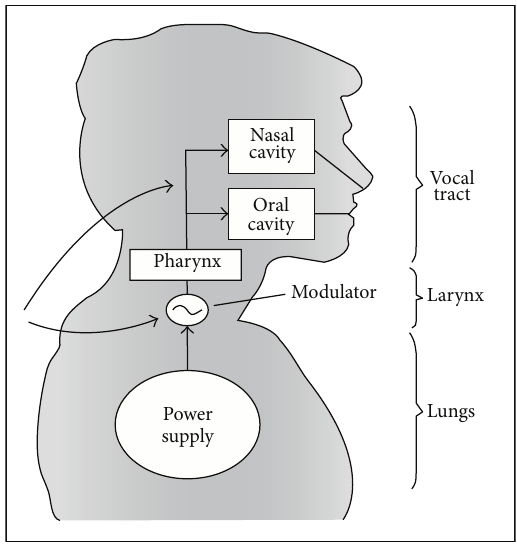
Figure 1: Simplified view of speech production [1].